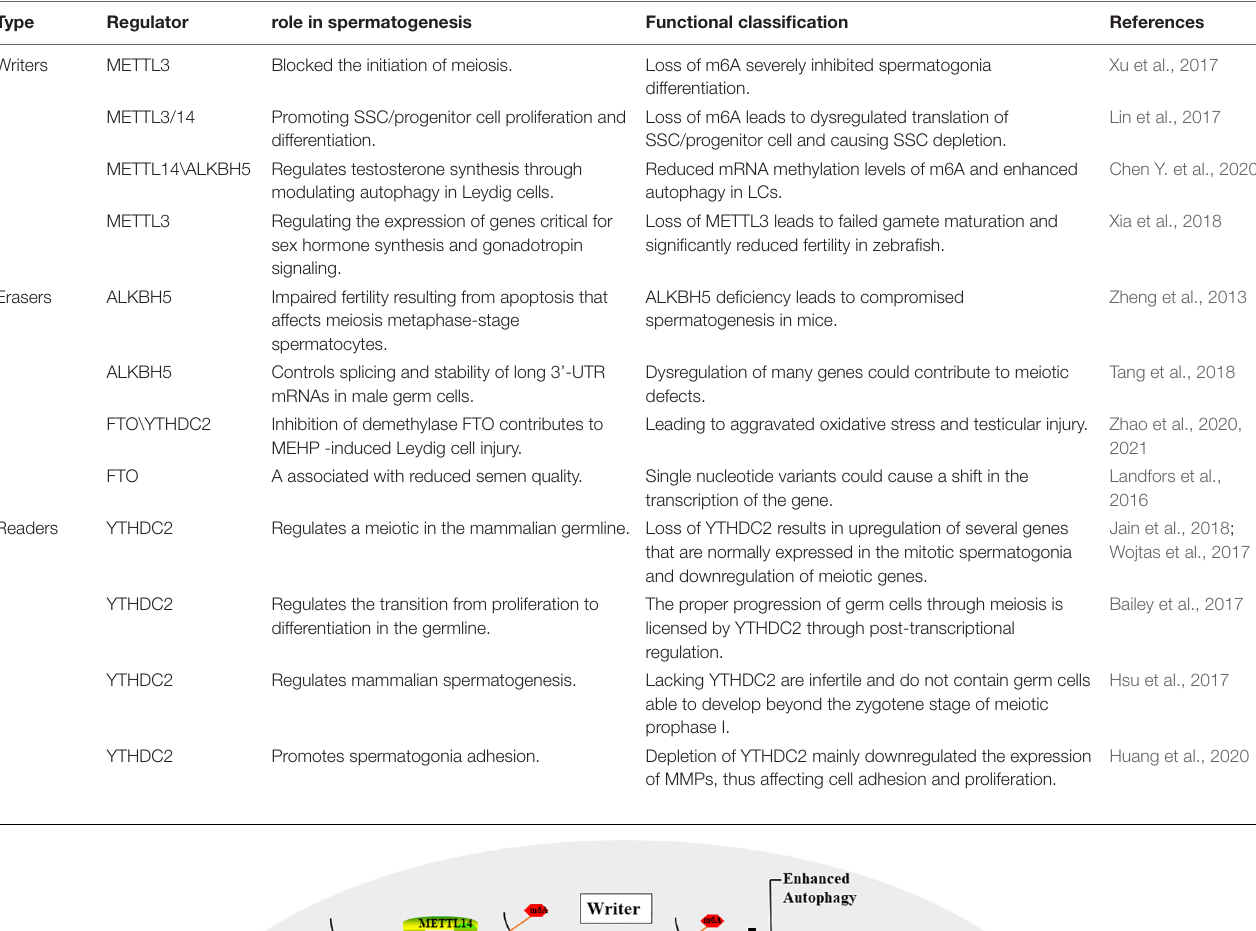
TABLE 1 | Roles of m6A proteins and biological mechanisms exerted in spermatogenesis.